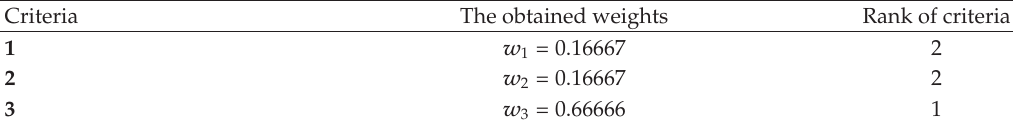
Table 1: The result of proposed method for Example 2 (cid:2) see Section 4.1 (cid:3) . Criteria The obtained